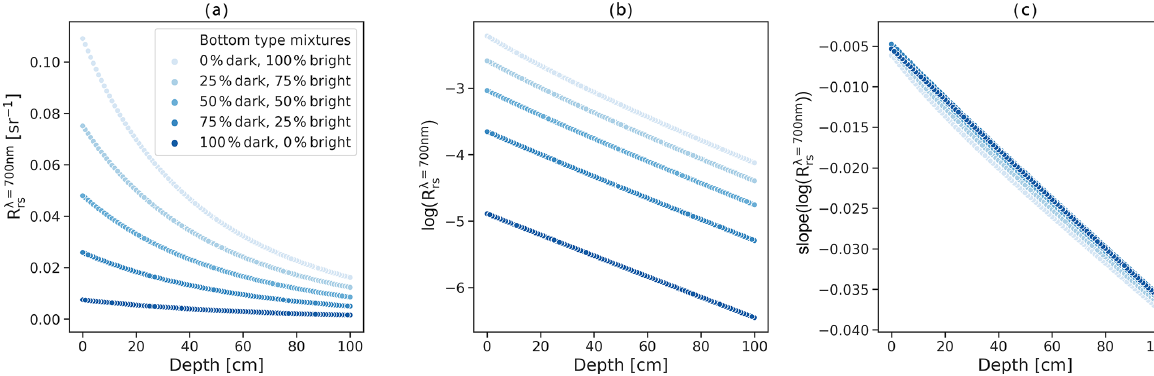
Figure 7. Processing of spectral data exemplified for λ = 700nm.